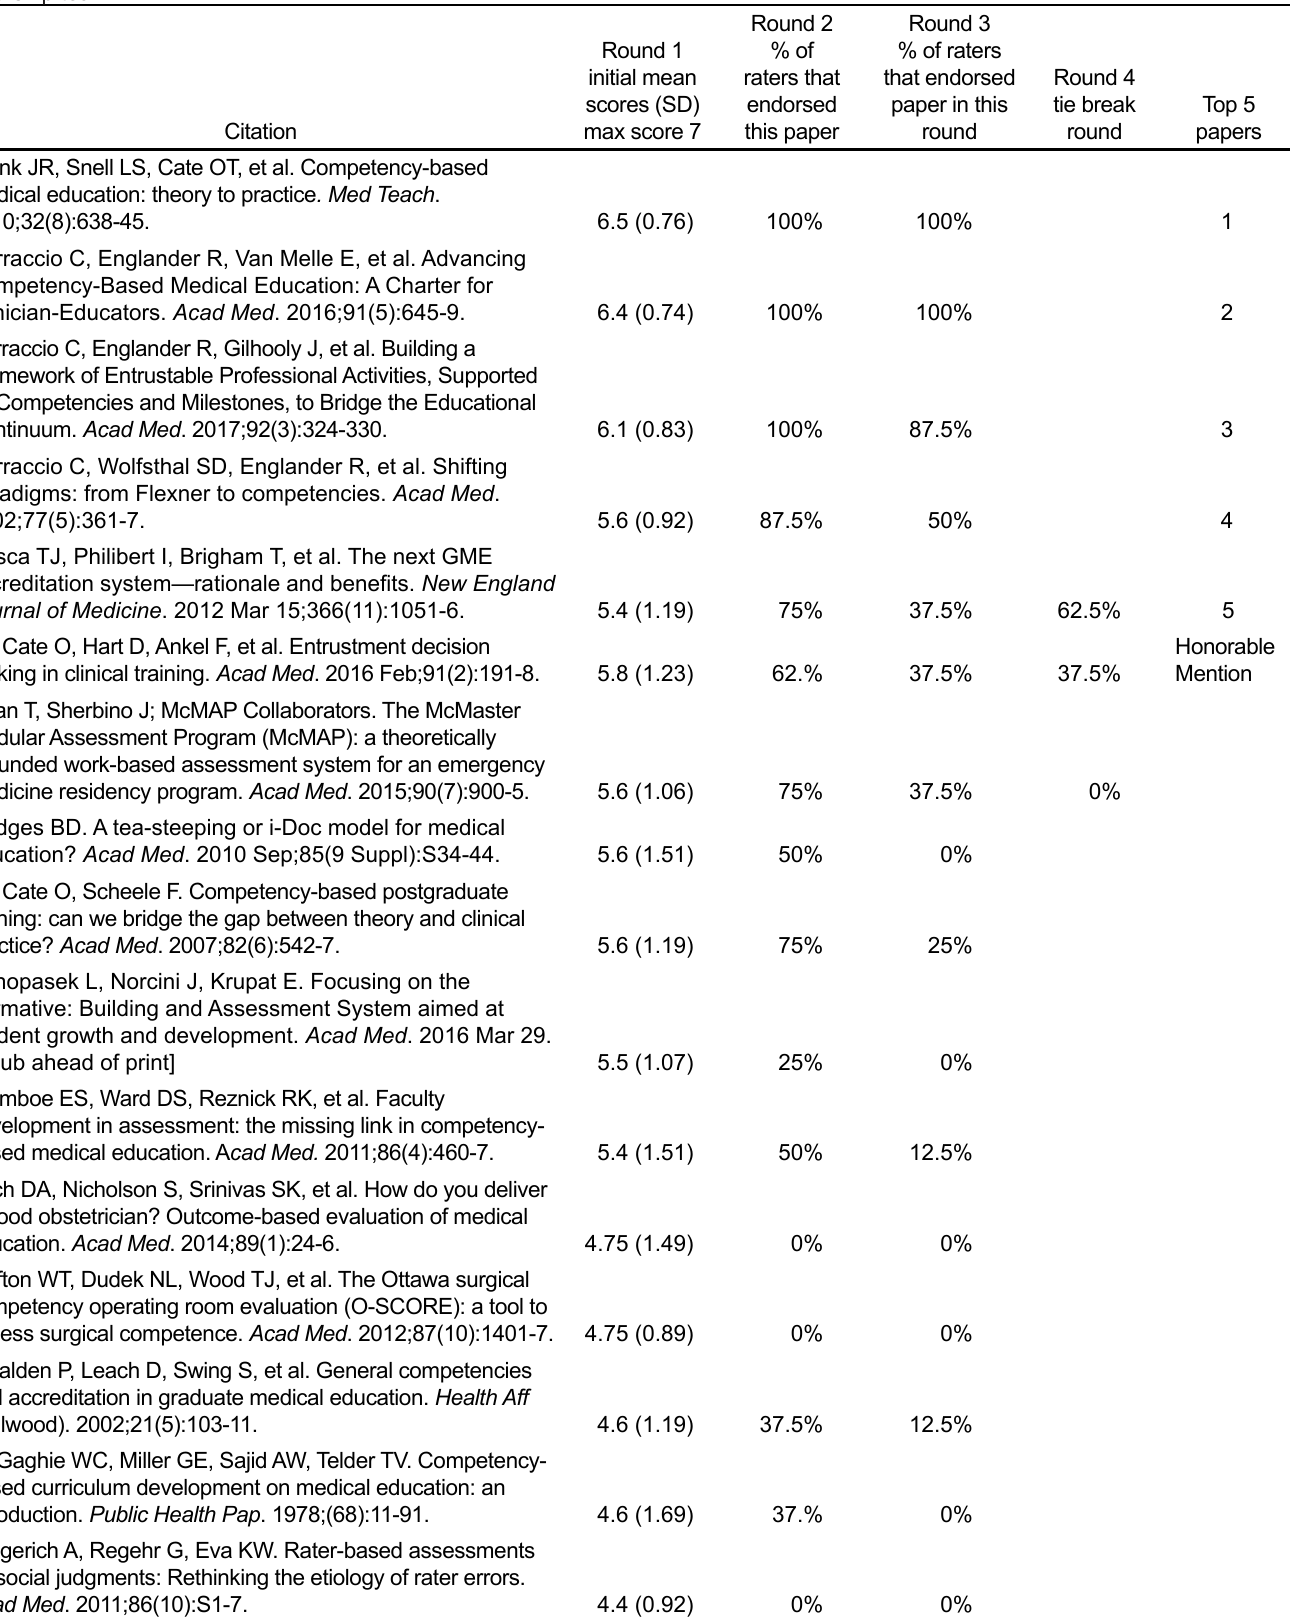
Table. The complete list of educational scholarship literature related to competency-based medical education that was collected by the authorship